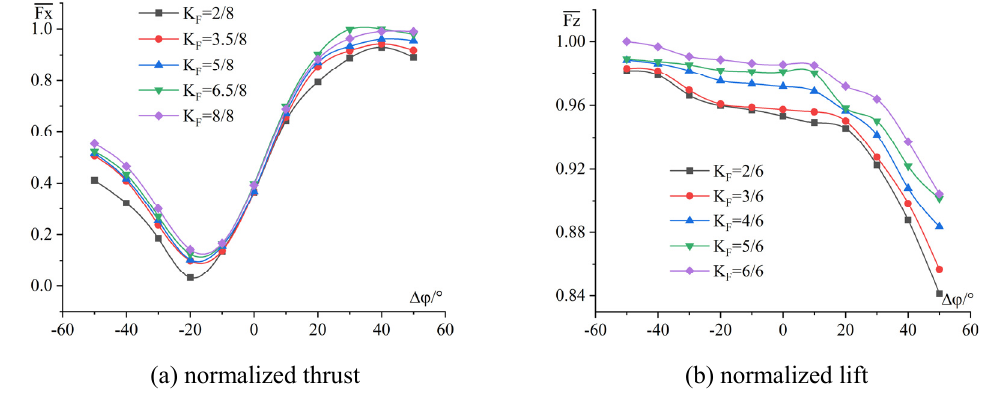
Figure 9. Effect of phase difference on leading edge.